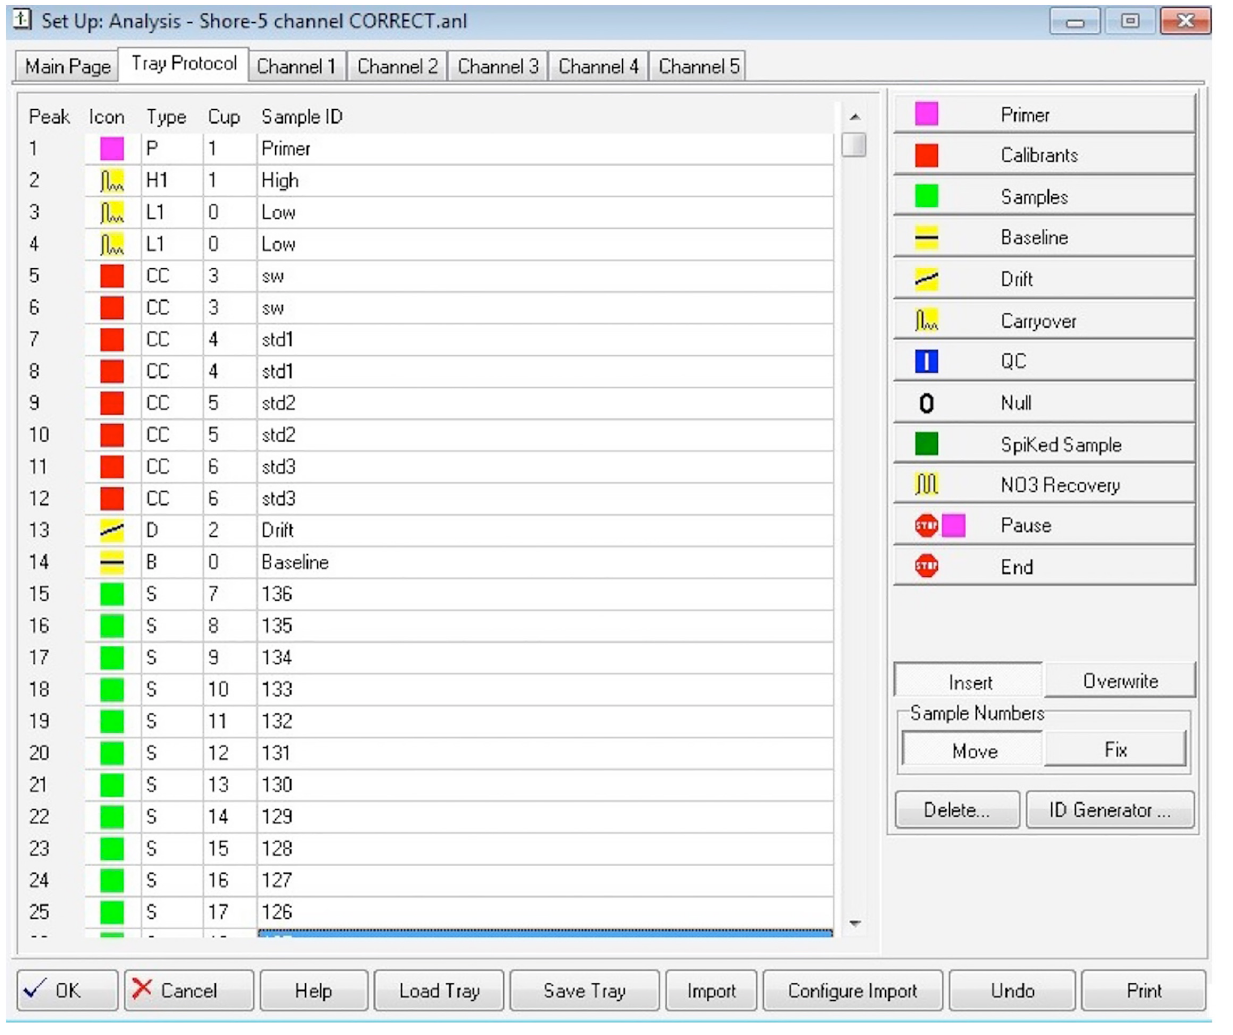
FIGURE 1 | An example of a tray file, in this case from the AACE software used with the SEAL AA3 analyzer. Also note the four standard concentration levels used in each run, as explained in section